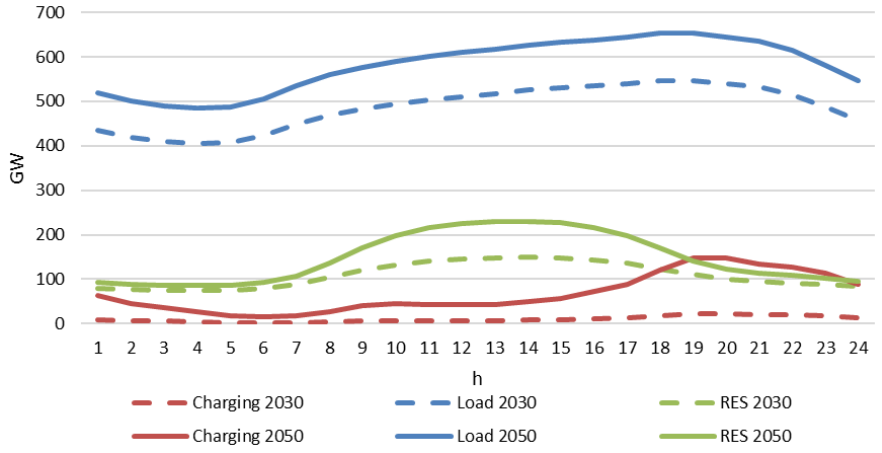
Figure 10. Charging, load, and RES profiles.